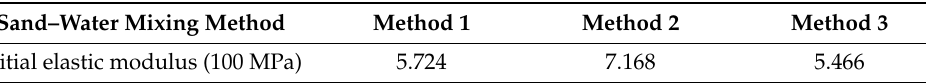
Table 1. The initial elastic modulus of the test